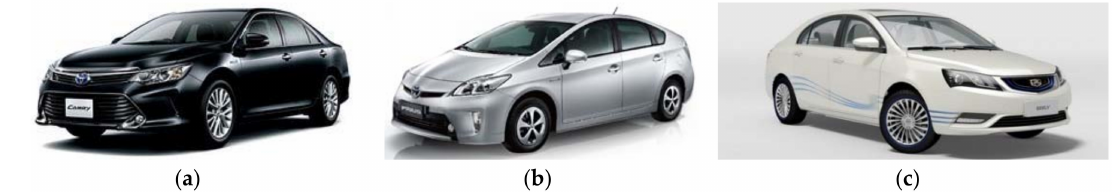
Figure 31. Examples of Ni/MH batteries in transportation applications: ( a ) a Camry HEV (Guangzhou Auto), ( b ) a Prius HEV (FAW), and ( c ) an EC7 HEV (Geely